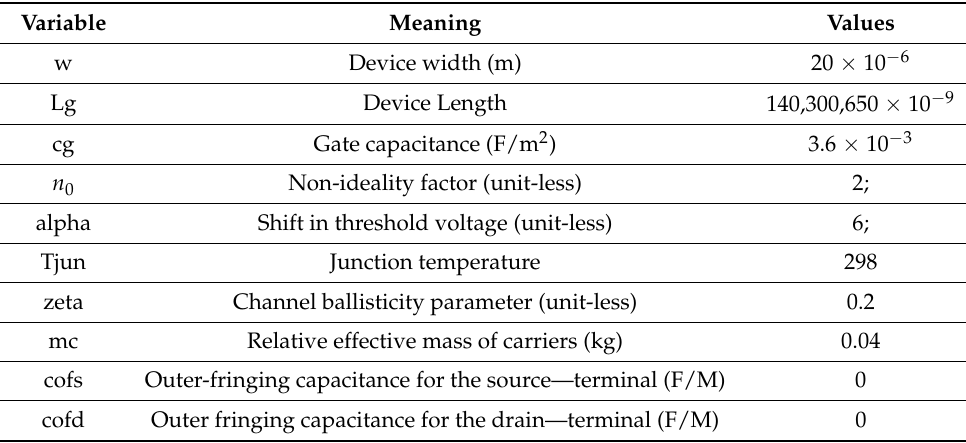
Table 1. Fixed parameters in the AVS v1.0.0.